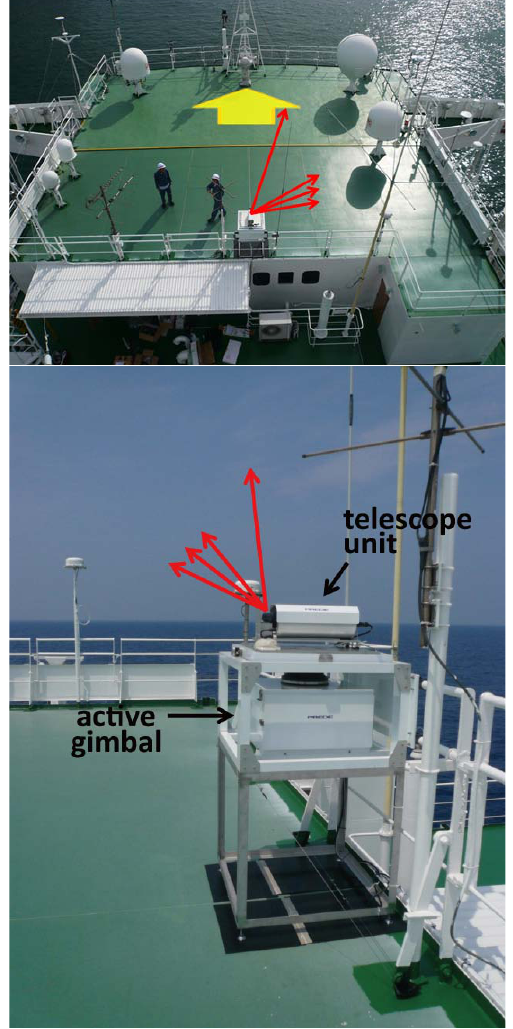
Fig. 2. Photographs of the outdoor unit of the MAX-DOAS instru- ment installed on the top deck of the R/V Kaiyo . The telescope unit was mounted on an active gimbal to ensure it was kept horizontal. The yellow arrow indicates the travelling direction of the ship. The line of sight of the instrument was toward starboard.